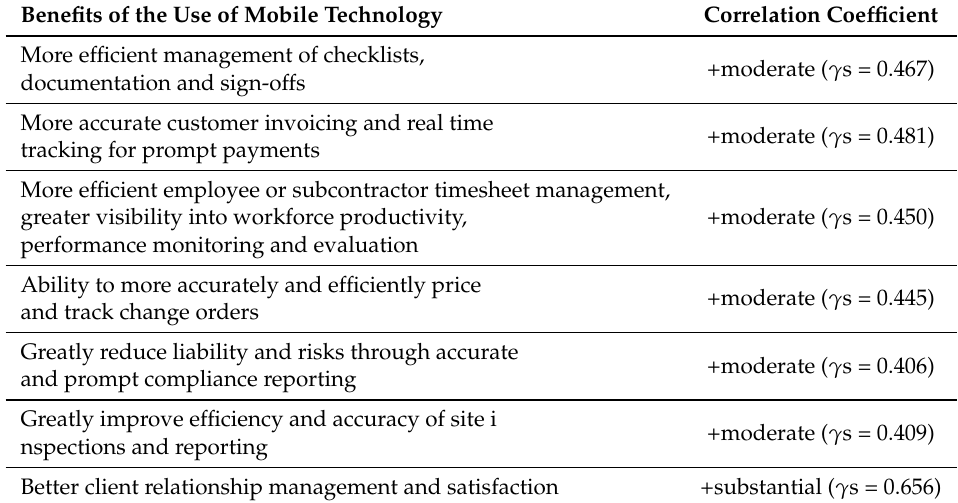
Table 5. Spearman Rho Test Results: Perceived Benefits Towards Overall